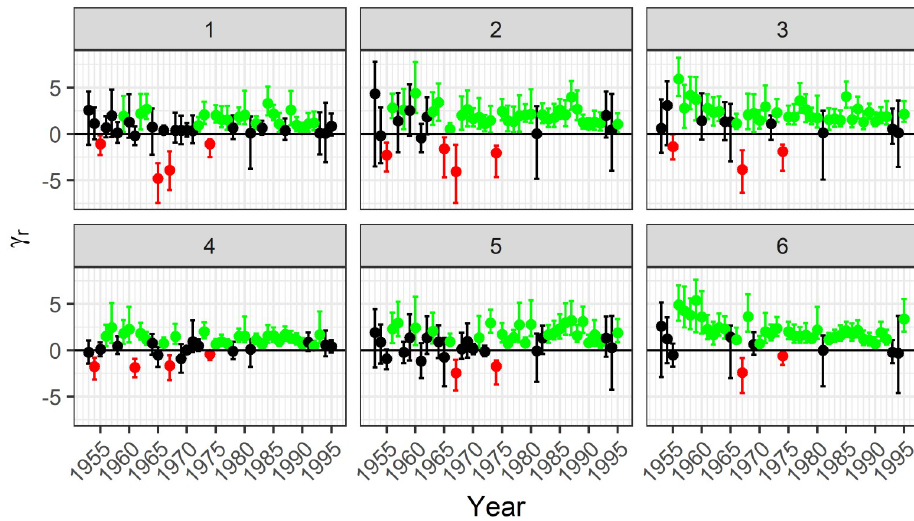
Fig 4. Posterior median estimates and 90% credible intervals for the linking parameter in the model for person- caused fires. In contrast to lightning-caused fires, person-caused fires tend to have positive association.